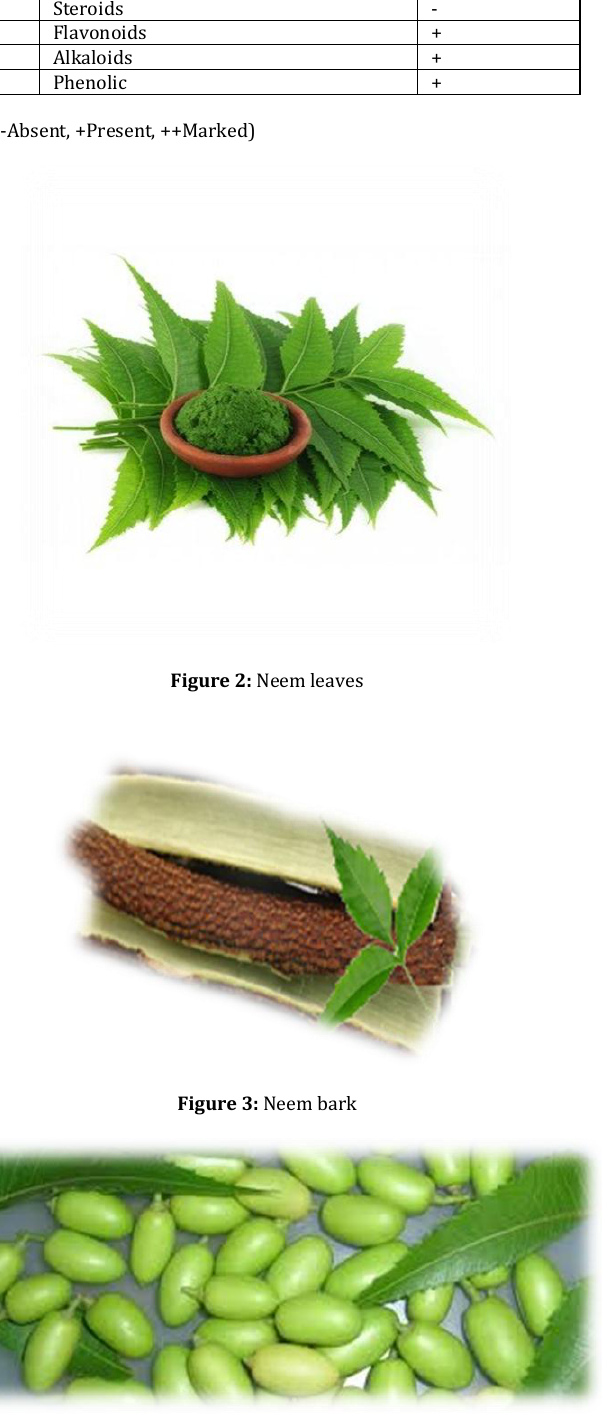
Figure 4: Neem seeds